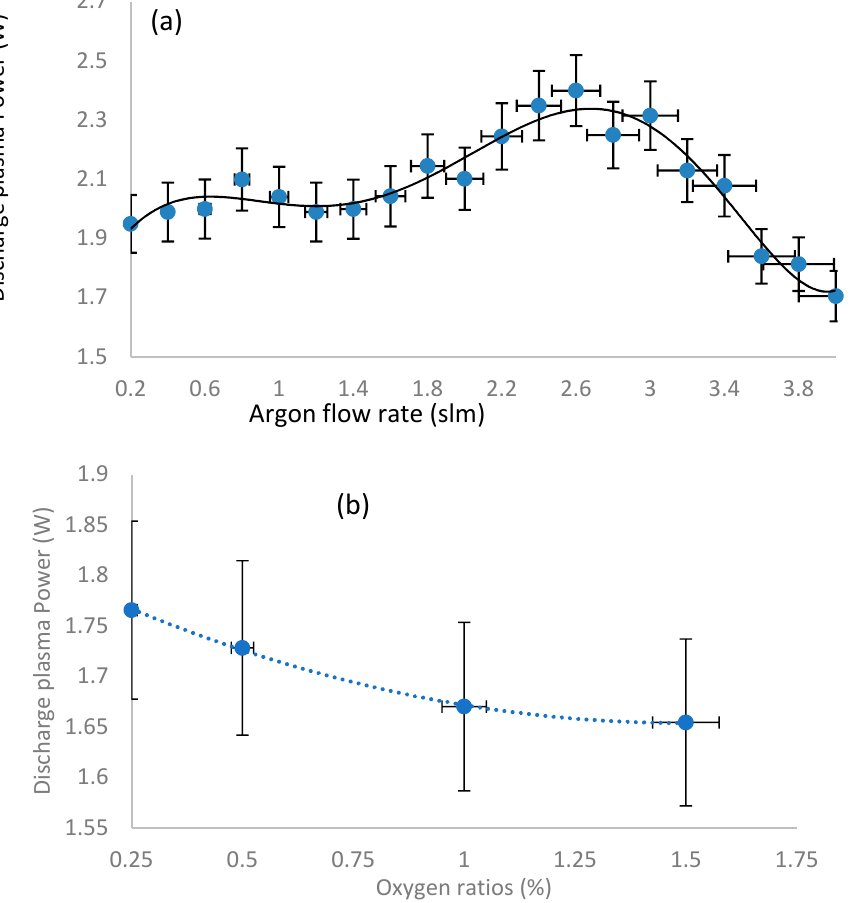
Figure 3. Influence of different flow rates on discharge plasma power ( a ) for pure argon, ( b ) for different oxygen ratios.